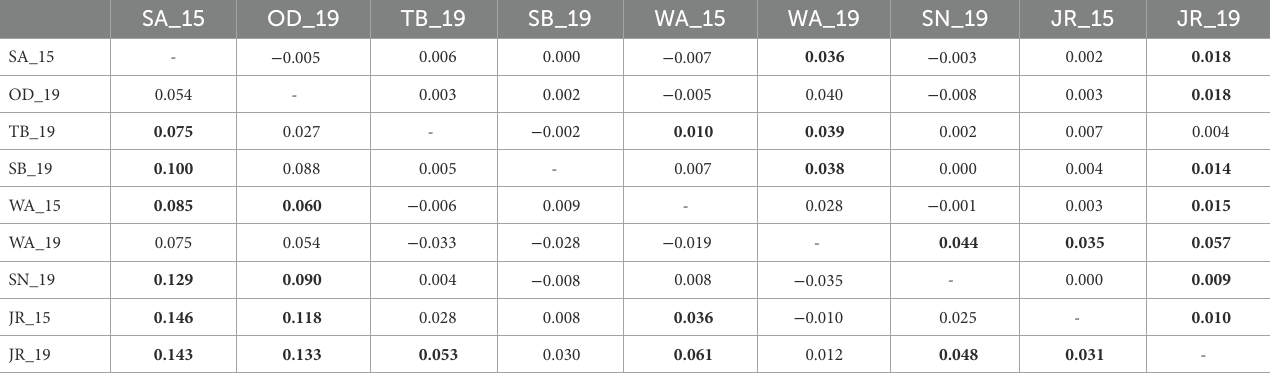
TABLE 2 Pairwise genetic differentiation ( F ST ) based on mtDNA cyt b sequences (below diagonal) and nine microsatellite loci genotypes (above diagonal) for nine national park populations of Apodemus agrarius within the Baekdudaegan Mountain Range (BMR).